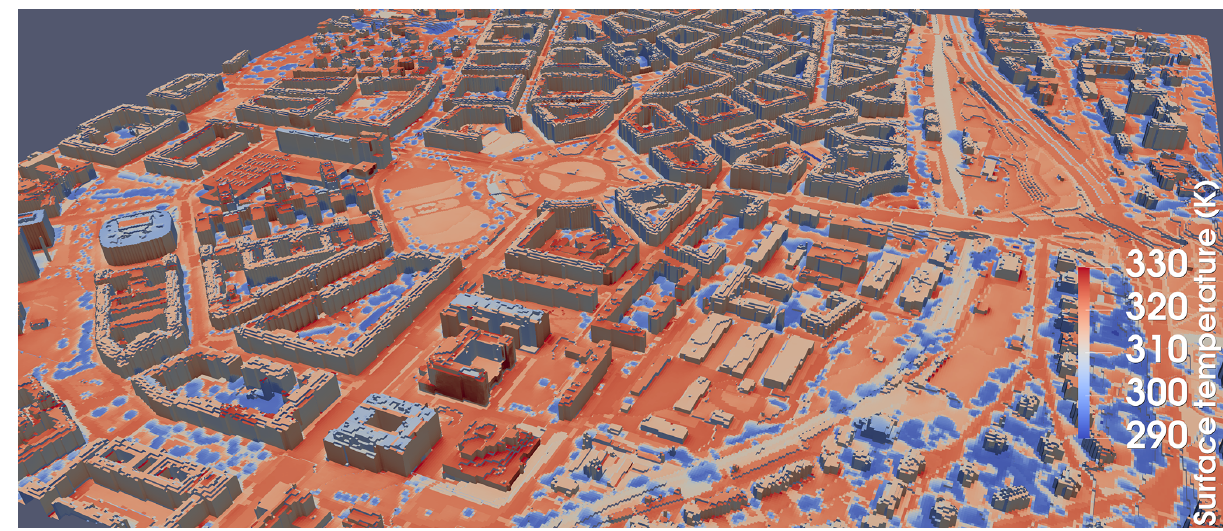
Figure 10. Example 3D view of the child modelling domain at 2m resolution from the south-west direction on 20 July at 13:00UTC (14:00CET). The colour scale represents the modelled surface